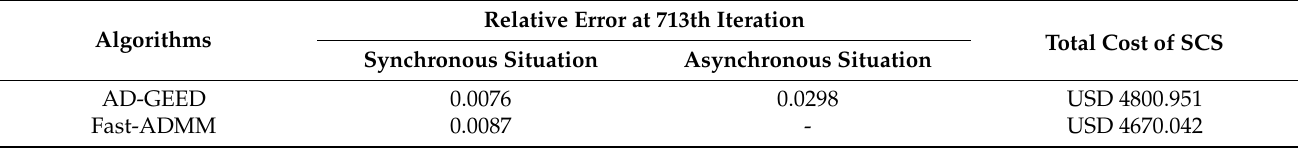
Table 2. Comparison of the two